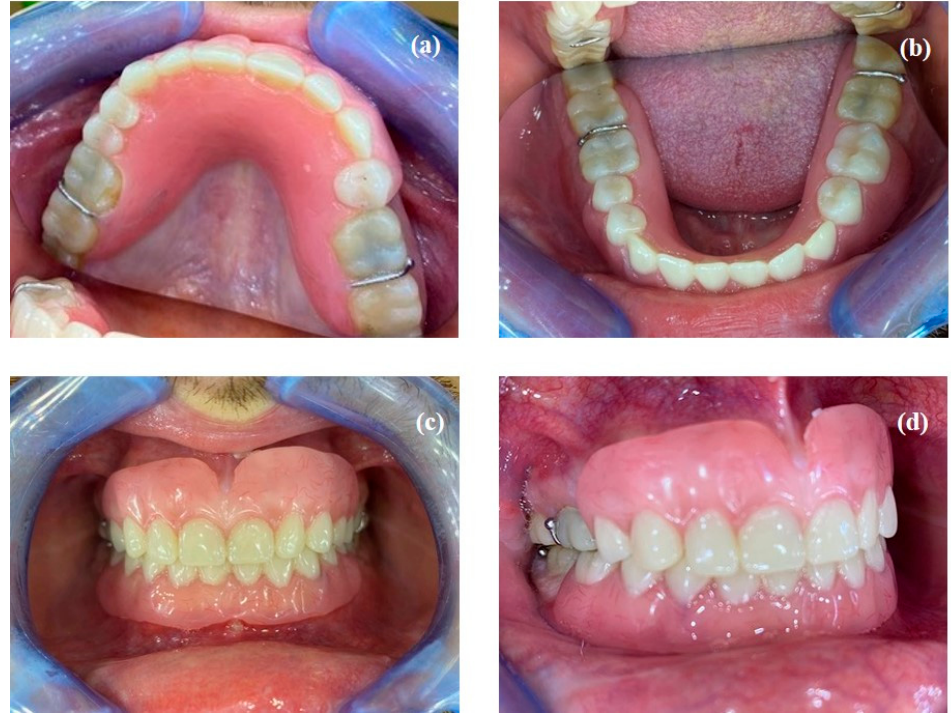
Figure 7. Resin mock-up and transitional removable partial dentures, ( a ) maxillary view; ( b ) mandibular view; ( c , d ) arches in occlusion.